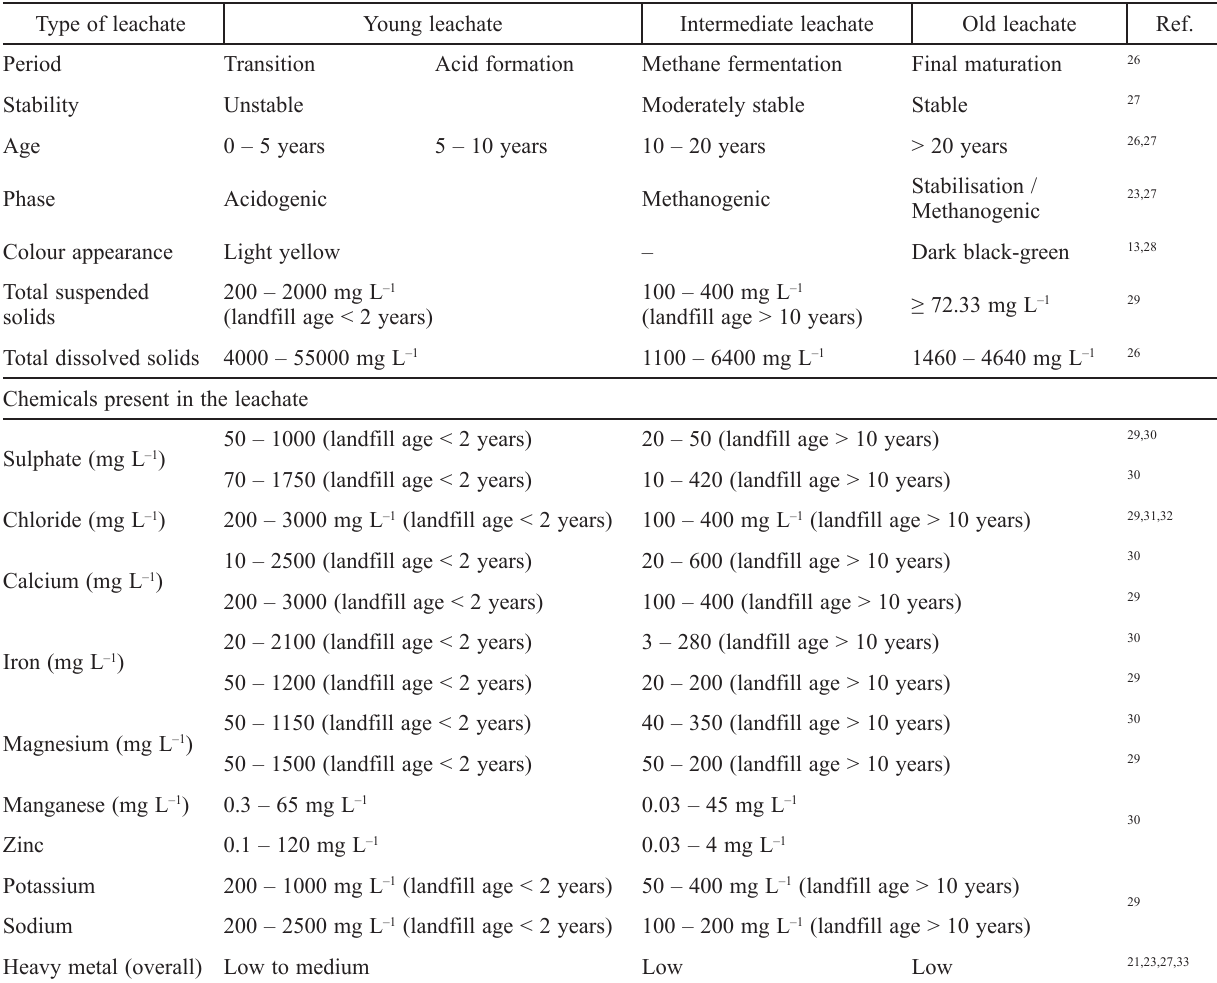
Table 3 – Properties and chemicals present in leachate as per their age (young leachate, intermediate leachate, and old